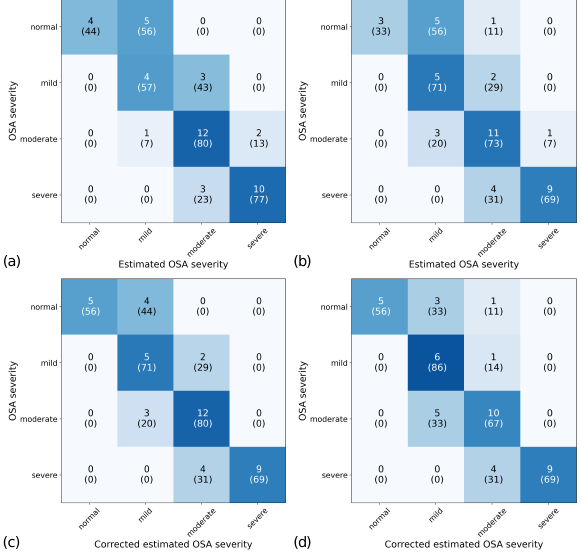
Figure 9. Confusion matrices for the estimation of OSA severity of the binary ( a ) and multiclass ( b ) models and the corrected estimated OSA severity of the binary ( c ) and multiclass ( d ) models. Data are presented as the number of participants with the row-normalized percentage in parentheses. The colors of the cells correspond to the row-normalized